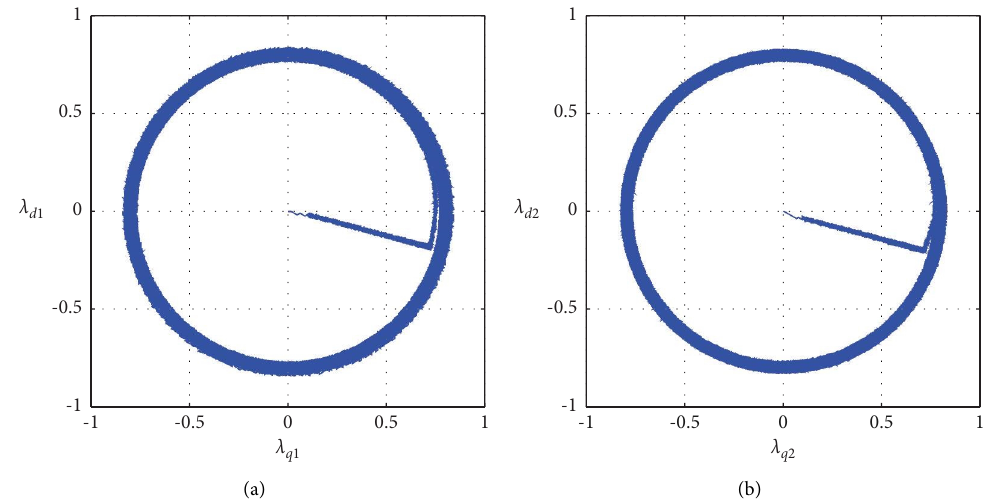
Figure 9: Two axes fux representation of (a) winding set A and (b) winding set X .